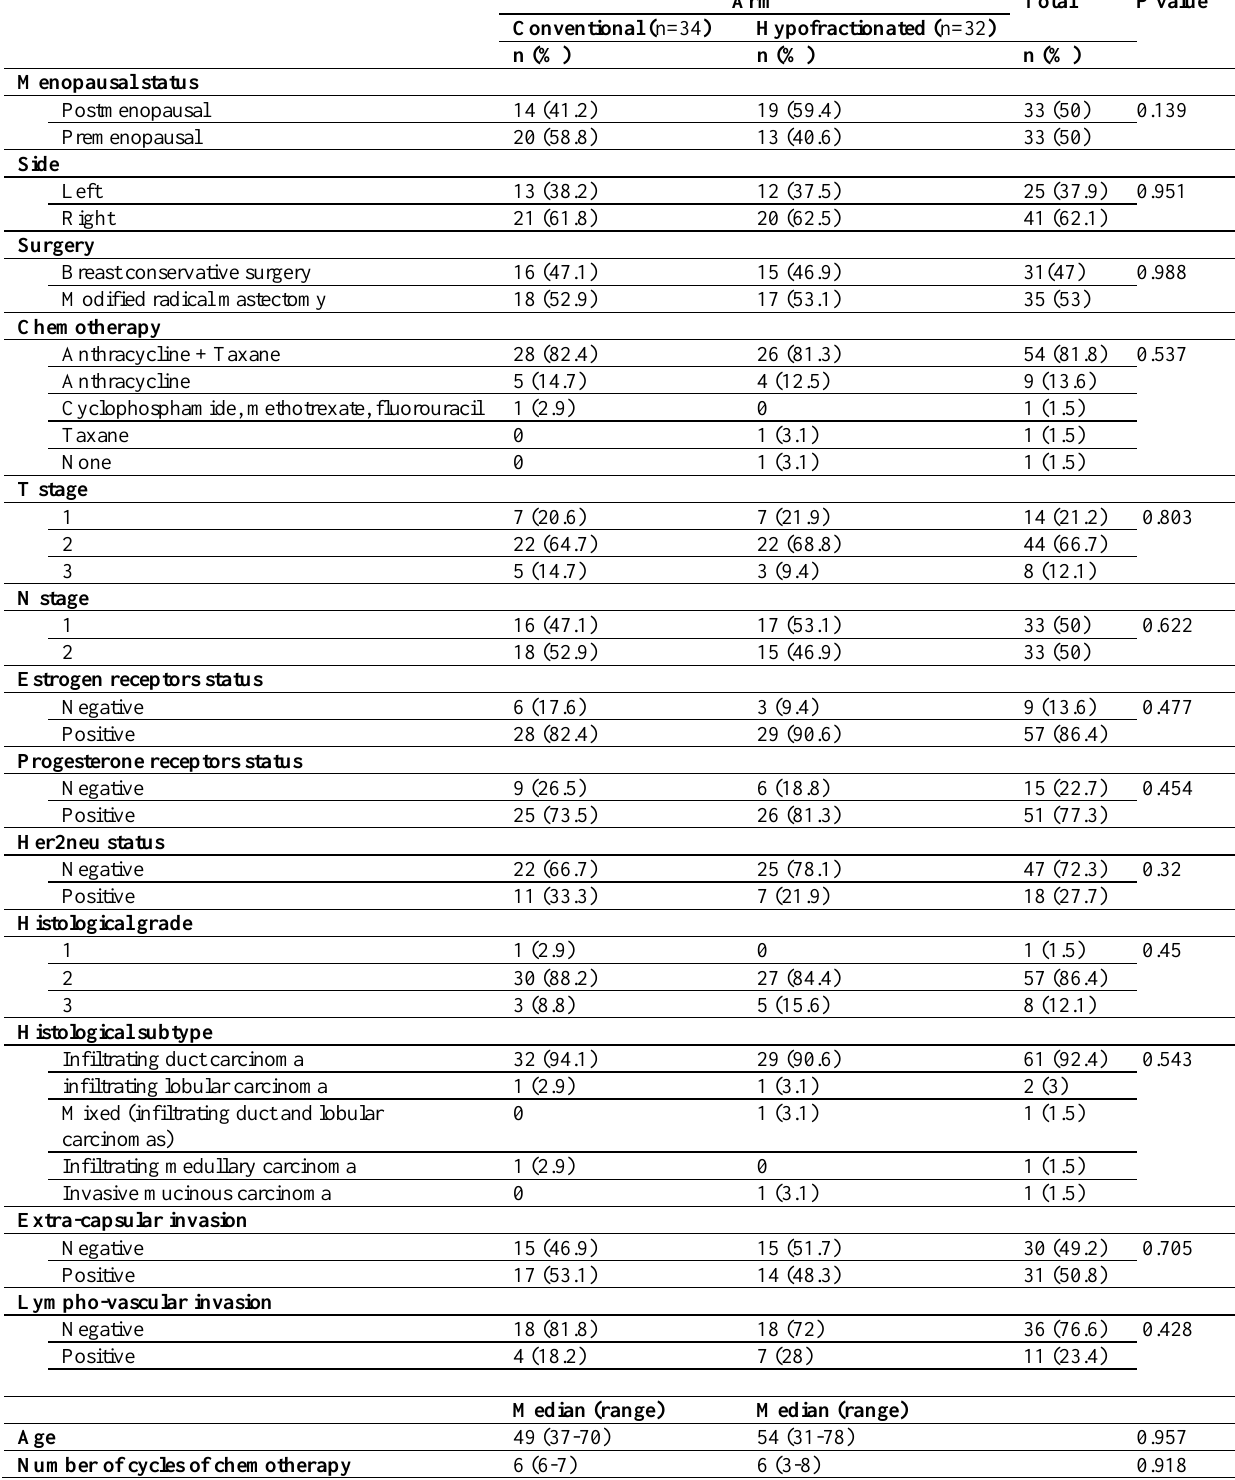
Table 2: Patients’ demographic and clinical